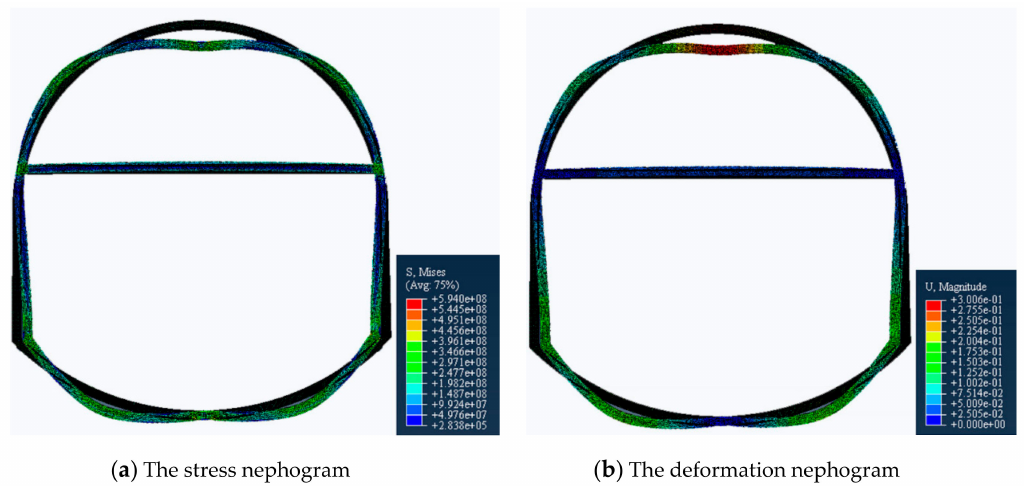
Figure 13. The stress nephogram and the deformation nephogram of RB set IV.